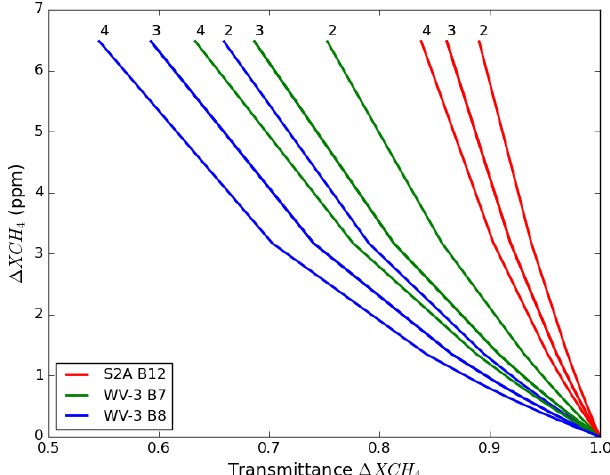
Figure 2. Relationship between the methane plume transmittance values and the methane column enhancement ( (cid:49) XCH 4 ) for the methane absorption bands ( ∼ 2300nm) of S2A B12, WV-3 B7, and WV-3 B8. The curves are given for three different values of AMF representing different angular conditions ranging from 0 to 60 ◦ (la- beled above as 2 to